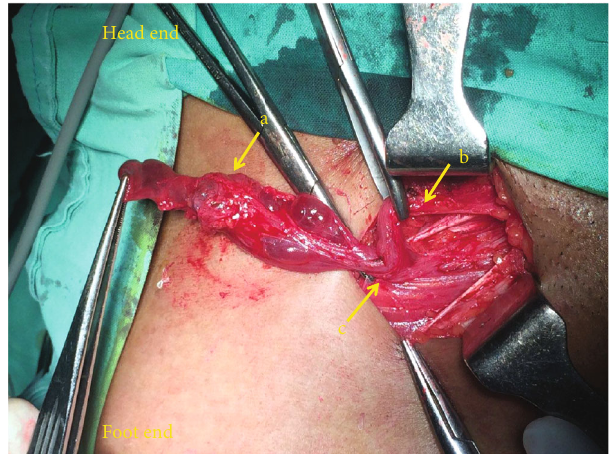
Figure 1: Intraoperative image of right inguinal canal. a — multiloculated cystic mass; b — round ligament of the uterus; c — deep inguinal